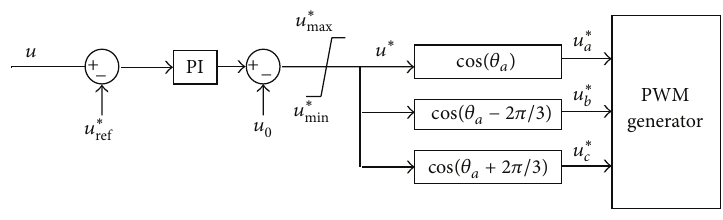
Figure 2: Schematic diagram of the V/F